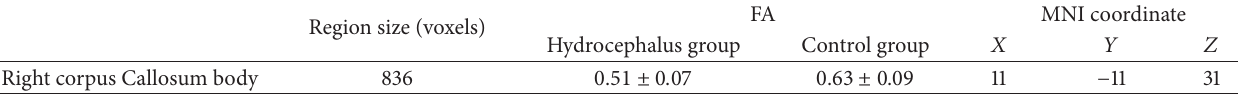
Table 3: Changes in FA values in hydrocephalus patients.